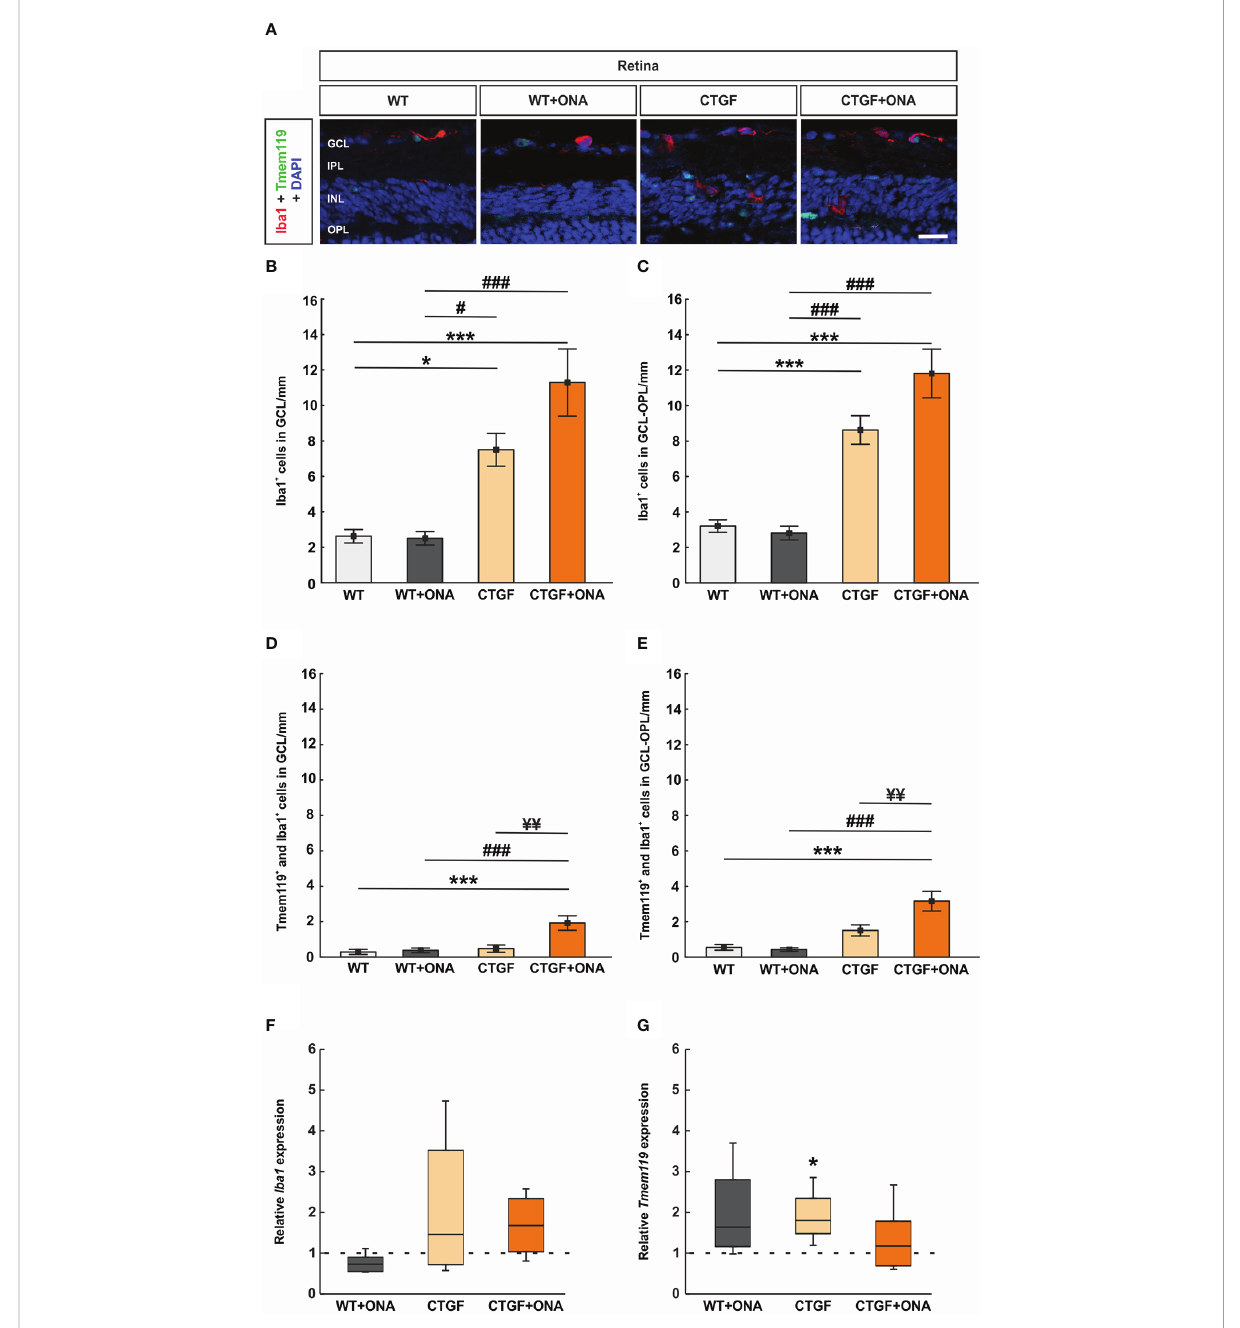
FIGURE 9 Increased microglia numbers in CTGF+ONA mice. (A) Retinal cross-sections were stained for microglia/macrophages with anti-Iba1 (red) and microglia with anti-Iba1 plus anti-Tmem119 (green). DAPI counterstained cell nuclei (blue). (B) The number of Iba1 + cells in the GCL was not different in the WT+ONA group compared to WT. Signi fi cantly more cells were observed in CTGF and CTGF+ONA retinae compared to WT or WT+ONA mice. (C) CTGF+ONA retinae displayed signi fi cantly more Tmem119 + and Iba1 + cells in the GCL compared to WT, WT+ONA, and CTGF animals. (D) The number of Iba1 + cells in the GCL to OPL was not altered in WT+ONA group in comparison to WT. Signi fi cantly more cells were observed in CTGF and CTGF+ONA retinae compared to WT or WT+ONA mice. (E) Signi fi cantly more Tmem119 + and Iba1 + cells in the GCL to OPL were observed in CTGF+ONA retinae compared to WT, WT+ONA, and CTGF animals. (F) No changes were noted in the Iba1 expression levels within all groups. (G) The mRNA expression levels of Tmem119 were not altered in WT+ONA and CTGF+ONA mice but were signi fi cantly upregulated in CTGF retinae compared to WT controls. GCL=ganglion cell layer, IPL=inner plexiform layer, INL=inner nuclear layer, OPL=outer plexiform layer. Values are mean ± SEM for immunohistology and median ± quartile ± minimum/maximum for RT-qPCR. The dotted lines in (F , G) represent the relative expression of the WT group. *p<0.05 and ***p<0.001 vs . WT; # p<0.05 and ### p<0.001 vs . WT+ONA; ¥¥ p<0.01 vs . CTGF. Scale bars: 20